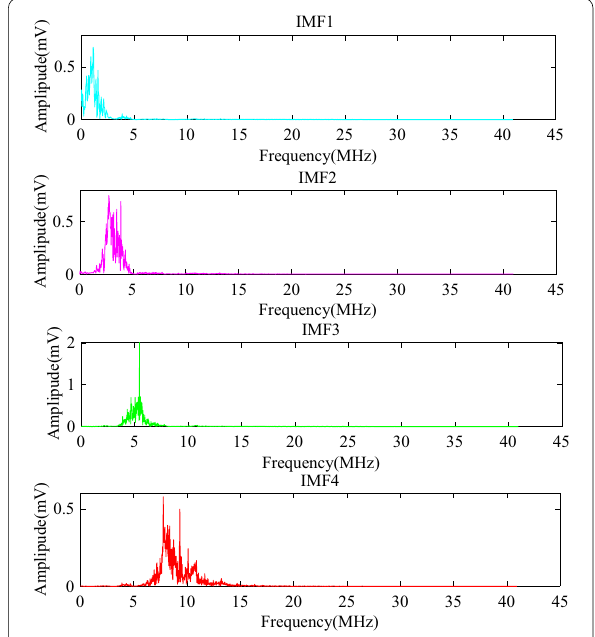
Figure 3 Frequency diagram of the intrinsic modal component when